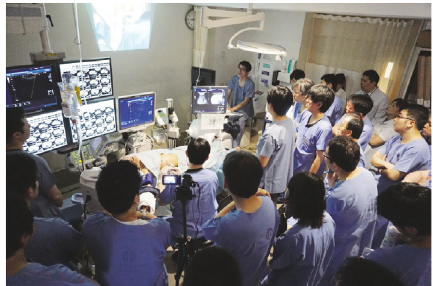
Figure 4: In live demonstrations, we perform ablation on various cases: a case of first diagnosed cancer not difficult to ablate judging from its size and location, a case of a tumor beneath the diaphragm requiring artificial ascites, a case of a tumor in the caudate lobe, a case of a tumor adjacent to the heart, a case of a tumor next to portal vein or hepatic vein at porta hepatis, a case of a tumor over 5 cm in diameter, a case of more than five tumors, cases of hepatic metastasis from the colorectal cancer or the gastric cancer, a case of simple nodular type HCC with extranodular growth or confluent multinodular type HCC, a case of a tumor with unclear boundaries on ultrasound which requires contrast-enhanced ultrasound to perform RFA, a case in which a tumor cannot be detected on ultrasound and requires support of fusion imaging, and others. From these cases, we demonstrate the importance of appropriate patient posture, usefulness of our original dedicated probe for inter- ventional procedures and our RFA dedicated operation table, and the way to carry out ablation under contrast-enhanced ultrasound guidance and with multimodality fusion imaging.